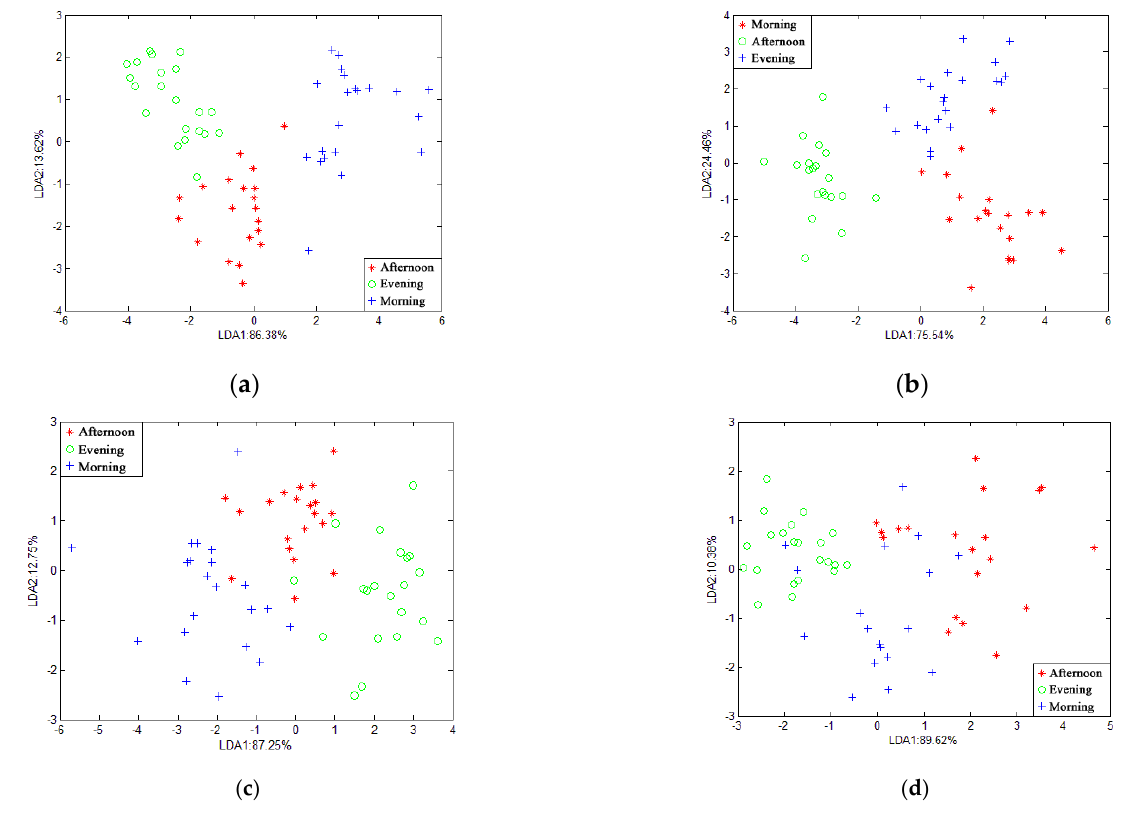
Figure 6. LDA chart of different times at the same position in the pig house with features of maximum values: ( a ) pregnancy-exhaust; ( b ) pregnancy-middle; ( c ) nursery-middle; ( d ) nursery-window. Table 4. The accuracy for odor classification in the same sampling location of piggery at different sampling times.